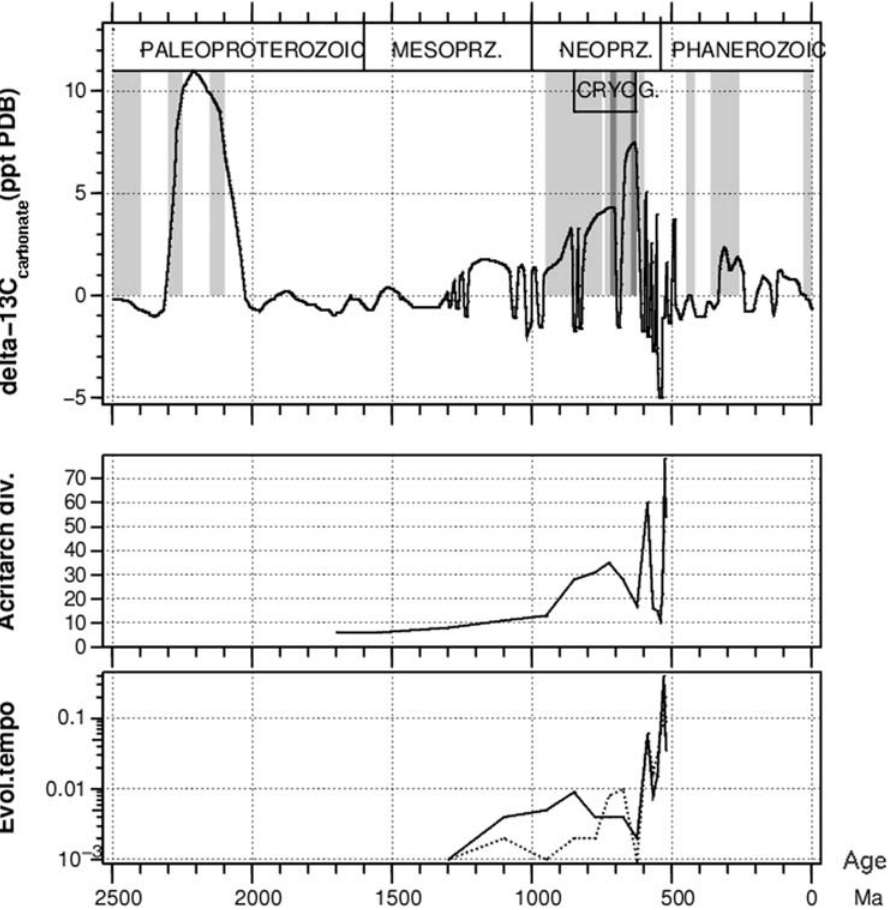
Figure 1. (a) Line: Deviation of d 13 C/ 12 C ratio from its standard Peedee belemnite (PDB) value in marine carbonate sediments. Adapted from [10]. Shadings show glacial periods: light shading means any geologic evidence of glaciation and darker shading means severe (global?) ice age. (b) Acritarch diversity; most acritarchs likely represent unicellular phytoplankton groups. (c) The evolutionary rate of acritarchs. Number of first apperance (solid) and last appearance (dotted) species per Myrs per species. Source for b and c is [30].